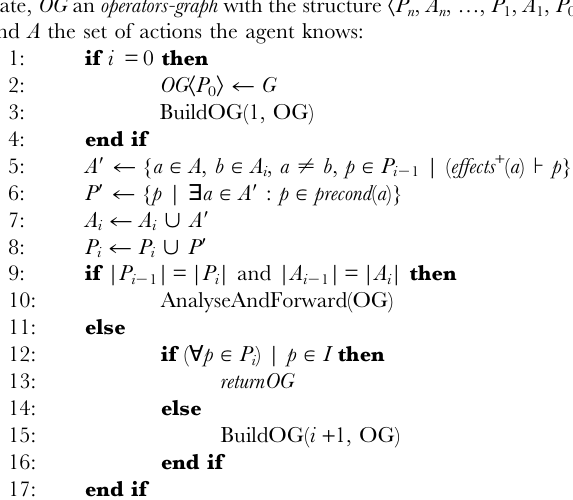
Algorithm 5 BuildOG(i, OG): Let i be the current level